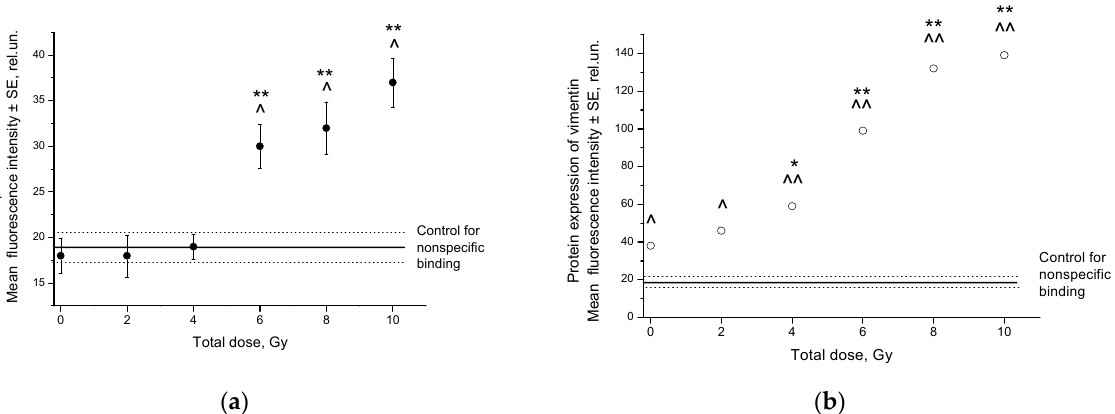
Figure 5. Protein expression of vimentin in SiHa ( a ) and HeLa ( b ) cells as determined using flow cytometry after staining exposed and unexposed cells with labeled antibodies to vimentin and snail hemocyanin (control for nonspecific binding). * p = 0.02 in comparison to unexposed cells. ** p < 0.001 in comparison to unexposed cells. ^ p < 0.01 in comparison to control for nonspecific binding. ^^ p < 0.001 in comparison to control for nonspecific binding. It is interesting to note that the protein expression of vimentin after irradiation at a dose of 2 Gy did not differ from that in unexposed cells of both lines. At the same time, the absolute number of SP cells increased significantly after radiation exposure at the same dose. The mRNA expression of vimentin in SiHa cells increased significantly 24 h after each dose fraction in a range of 2–10 Gy compared to that in unexposed cells (Figure 6a). The dose-dependent increase in mRNA expression persisted in the TD range of 4–10 Gy for 8 days after irradiation (Figure 6b), although it slightly decreased compared to the short- term effects at 24 h.